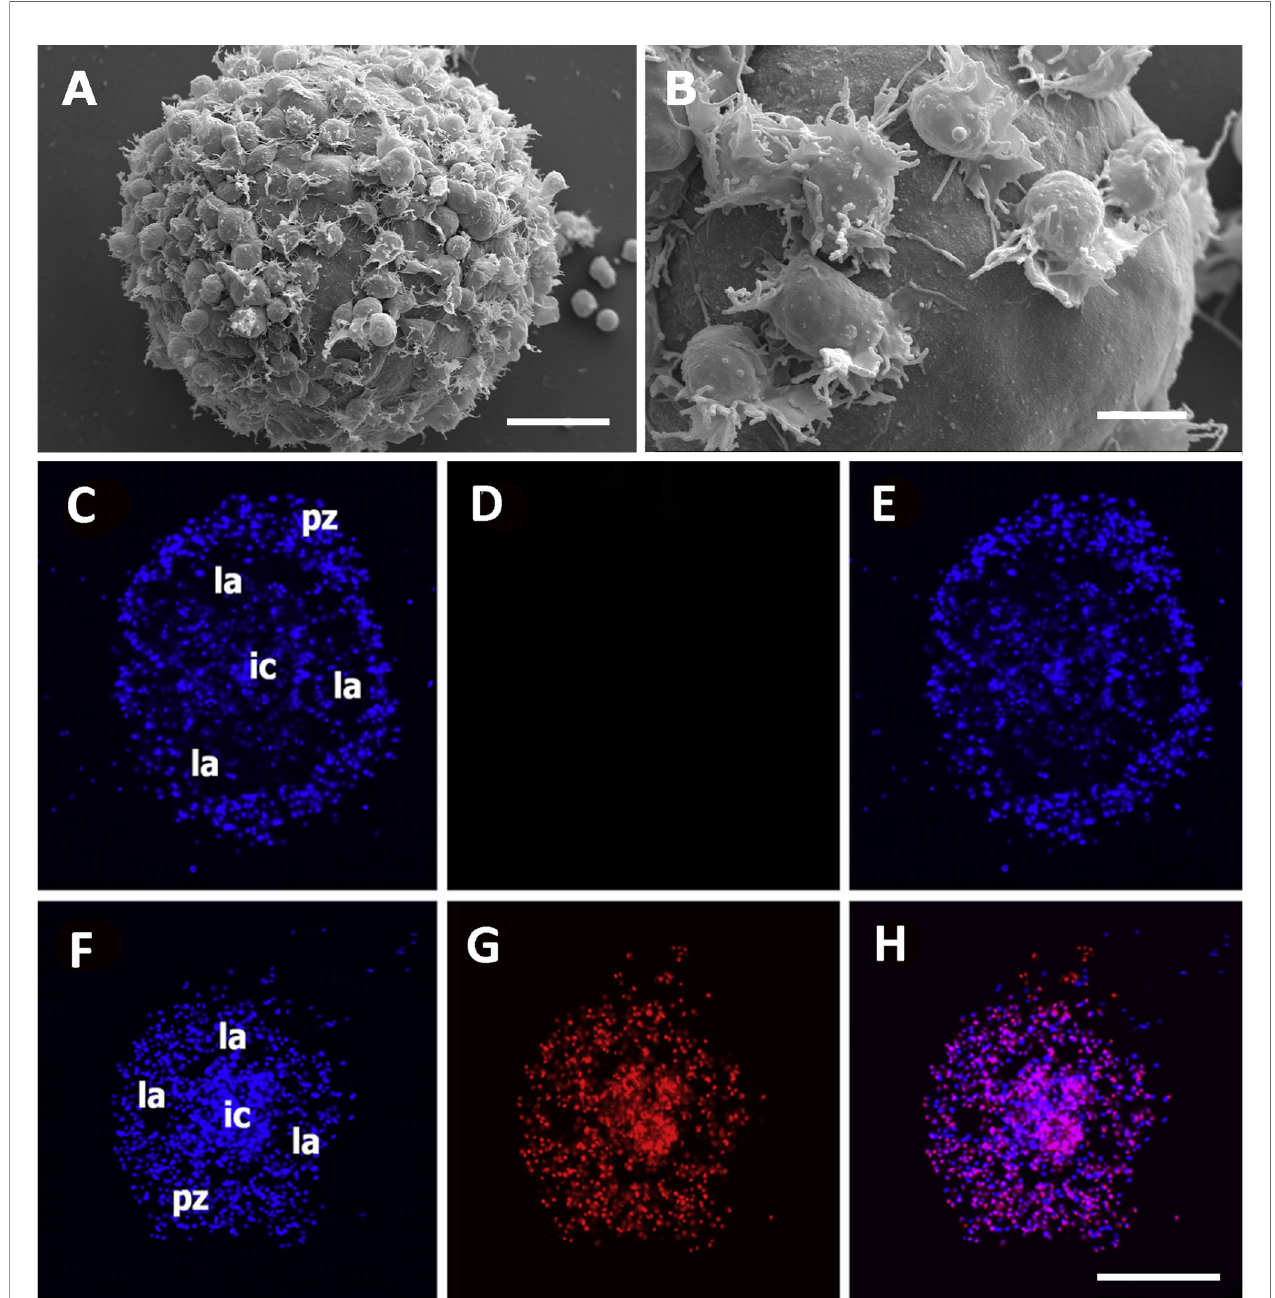
FIGURE 9 | Hemocyte aggregates in vitro . (A) Large nodule mostly covered by fi lopodia/lamellipodia emitting cells, 96 h after seeding; scanning electron microscopy; scale bar represents 20 µm. (B) Detail of the smooth external aspect of a nodule, with some fi lopodia/lamellipodia emitting cells on it, 96 h after seeding; panels (A, B) are scanning electron microscopy micrographies; scale bar represents 10 µm. Panels (C – H) Floating hemocyte aggregates in culture, 72 h after seeding (DAPI and propidium iodide staining; laser confocal microscopy). (C) Hemocyte nodule grown in vitro showing the peripheral cell zone, the intermediate lacunar zone, and the inner core (DAPI emission, blue). (D) Same hemocyte aggregate lacking propidium iodide staining (red emission), indicating that all cells were viable. (E) Merging of micrographs (C, D) . (F) . Another aggregate showing the same basic organization (DAPI emission, blue). (G) Same aggregate showing abundant cells marked with propidium iodide (red emission), indicating that most cells in this aggregate were not viable. (H) Merging of micrographs (F, G) . Scale bar for panels (C – H) represents 100 µm. IC, inner core; LA, lacuna; PZ, peripheral zone. From